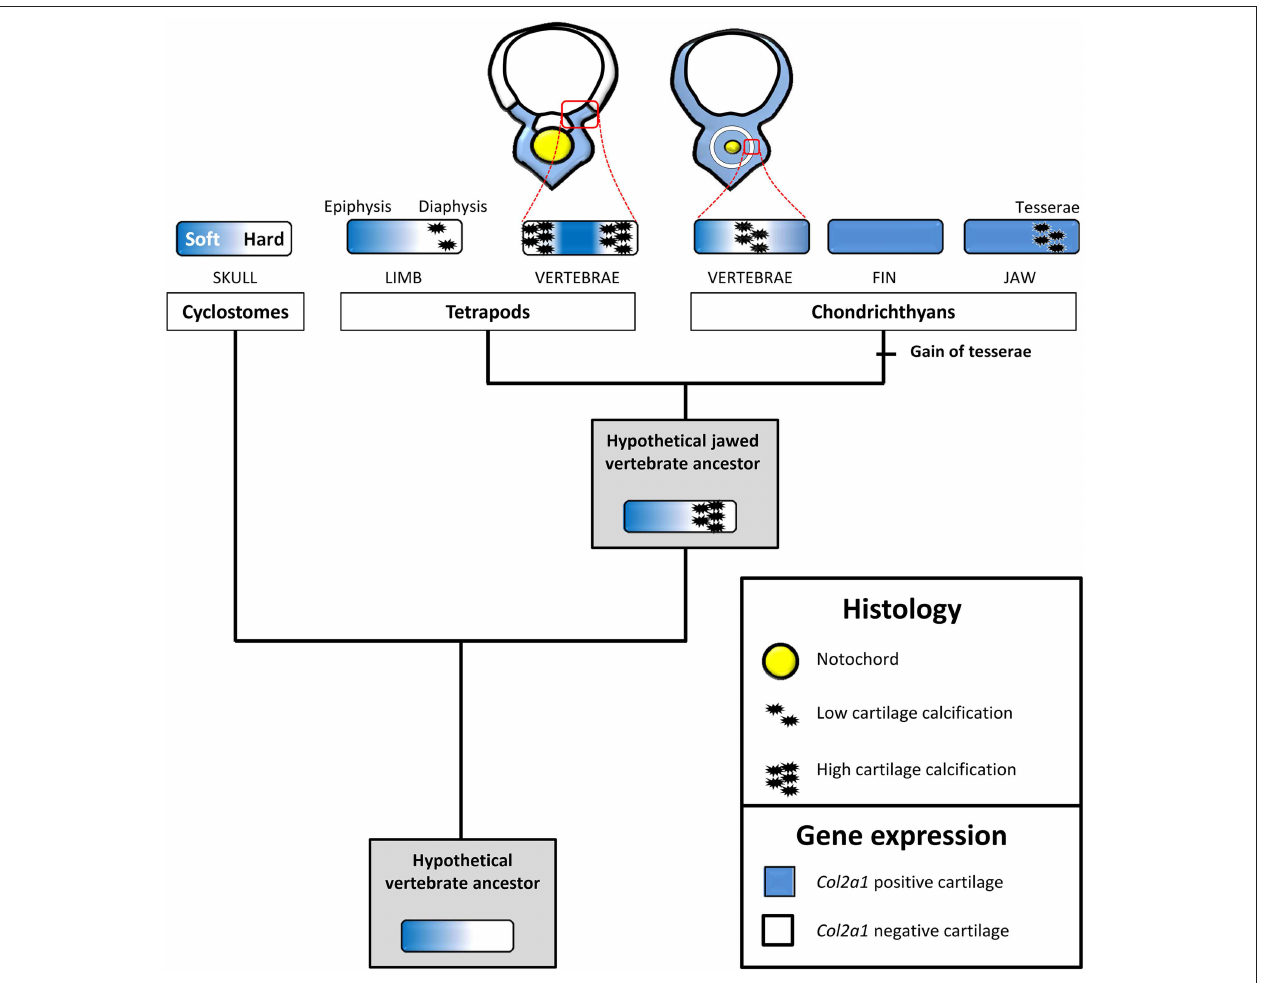
FIGURE 7 | An evolutionary scenario for cartilage calcification in jawed vertebrates. Expression patterns and cartilage matrix calcification were mapped onto a simplified vertebrate phylogenetic tree to deduce ancestral states and polarize evolutionary change. We propose that, in the last vertebrate common ancestor, the expression of Col2a1 experienced a strong downregulation in maturing, non-calcified, cartilaginous regions. This downregulation was subsequently inherited by distinct vertebrate lineages, and is associated to hard cartilage in cyclostomes and to calcified cartilage in jawed vertebrates. The chondrichthyan and osteichthyan representatives analyzed in this study display a calcified Col2a1 -negative vertebral cartilage, a likely jawed vertebrate synapomorphy. Tesserae calcification, a recent chondrichthyan innovation, occurs in the absence of Col2a1 downregulation. Perichondrium and bone have been omitted for the sake of simplicity. See text for details.